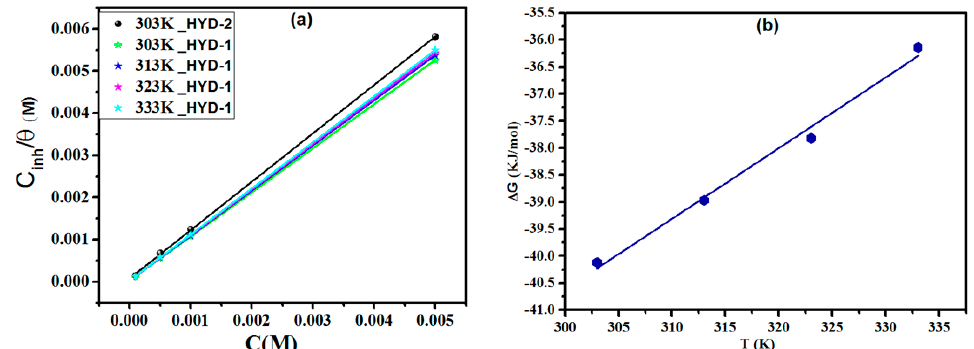
Figure 9. ( a ) Langmuir adsorption isotherm models and ( b ) the variation of standard Gibbs free energy of HYD-1 with temperature for the adsorption of inhibitor on MS in 1.0 M HCl.